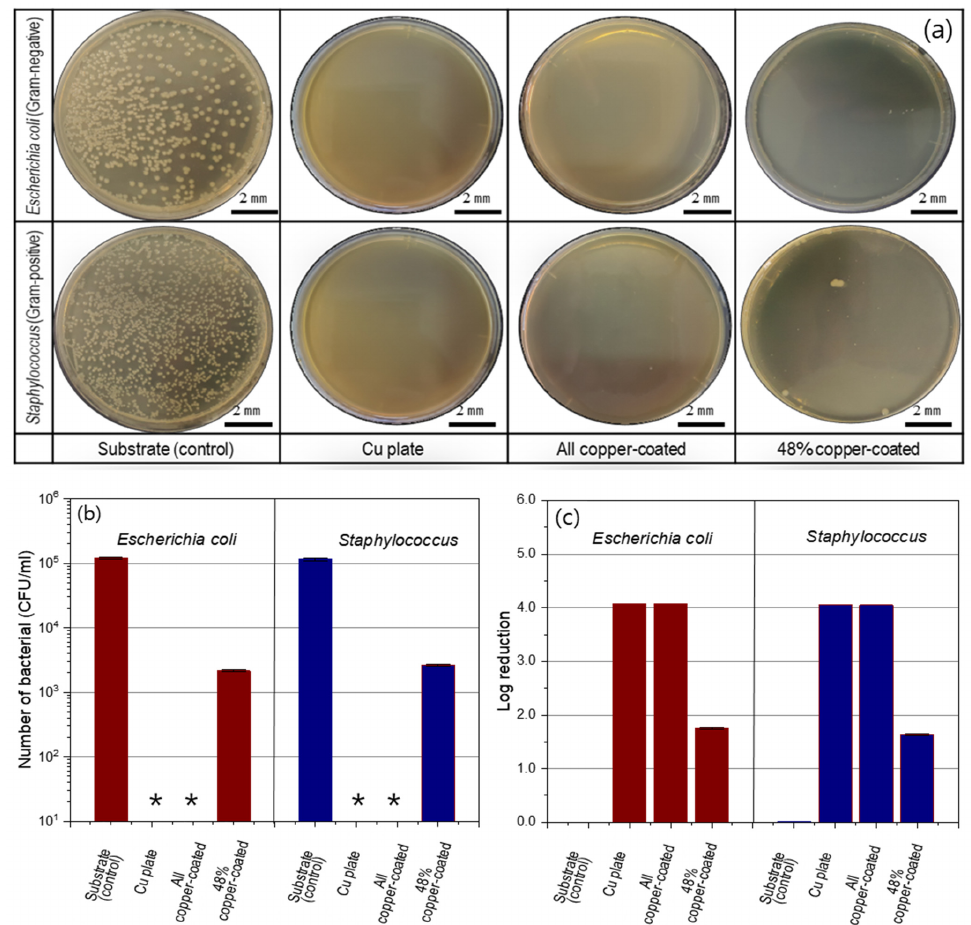
Figure 7. Antibacterial activity of the specimens determined by ISO 22196:2011. ( a ) Images of colonies after 24 h of incubation for Escherichia coli and Staphylococcus (dilution factor of 10 − 2 ), ( b ) quantified number of bacterial (* indicates that no colony was observed, limit of detection < 10 CFU/mL) and ( c ) log reduction in the different groups. The data are expressed as mean ± S.D. of triplicates.